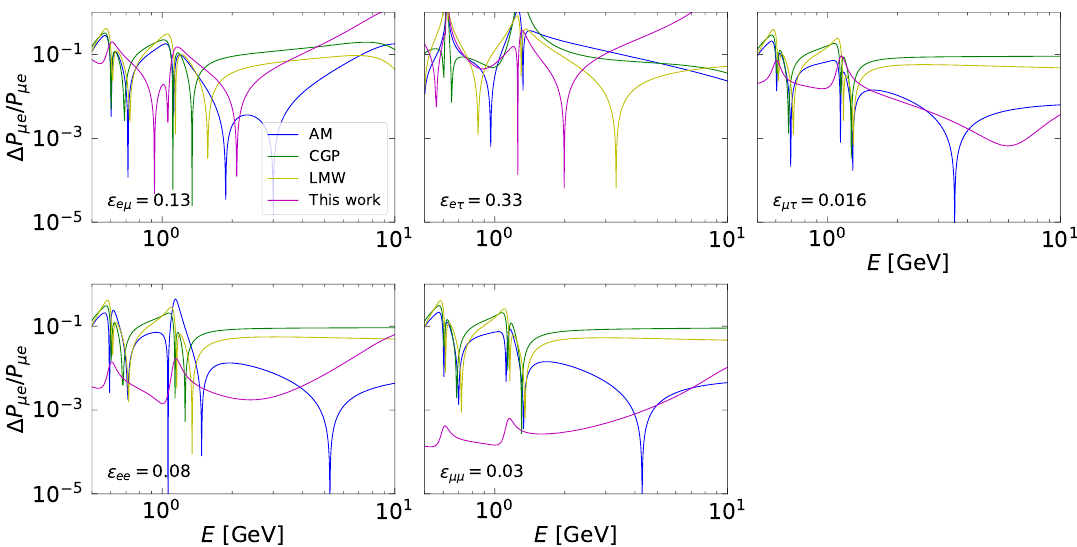
Figure 2 . Comparison of our approach with other formulas obtained in the literature. The fractional difference of probabilities ( ∆ P µe /P µe ) for different fixed values of ε αβ is plotted as a function of E . Each panel compares the precision for a single ε αβ . In the case of the non-diagonal parameters, the phases are set to zero, ϕ αβ = 0 . The average value of density is taken to be 2 . 95 g/cc which corresponds to L ’ 1300 km.